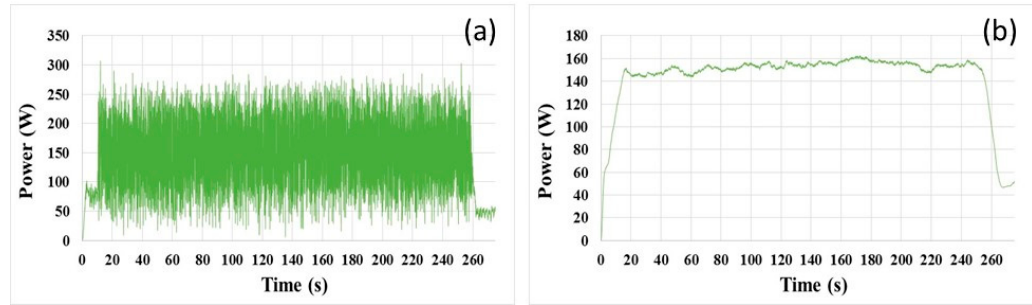
Figure 11. ( a ) Original motor power signal of polishing head; ( b ) Smoothed signal curve of (a).